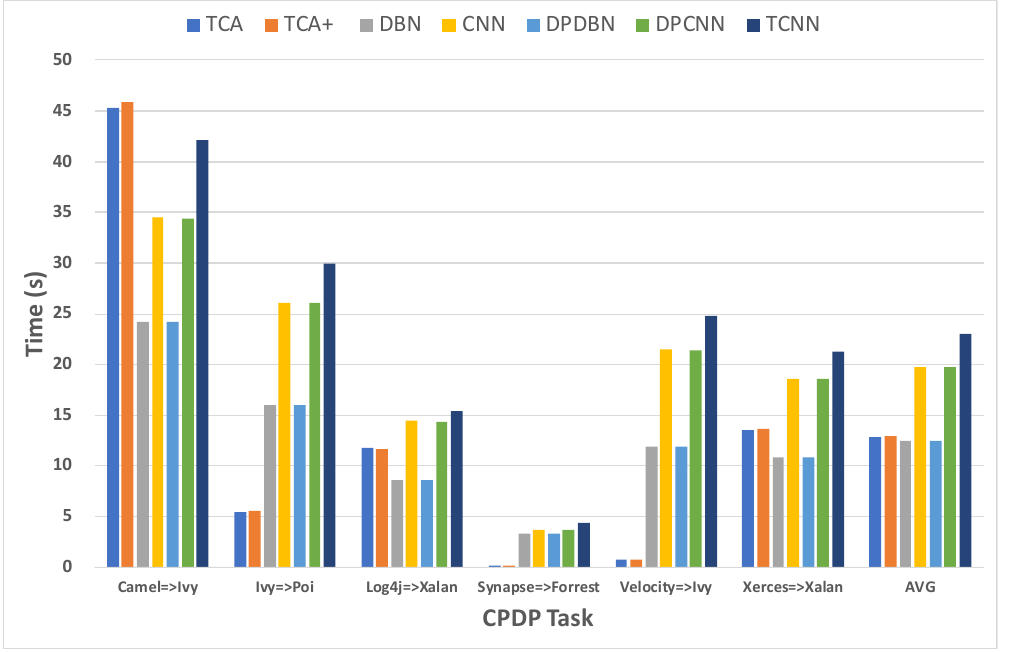
Figure 6. Comparison of model training